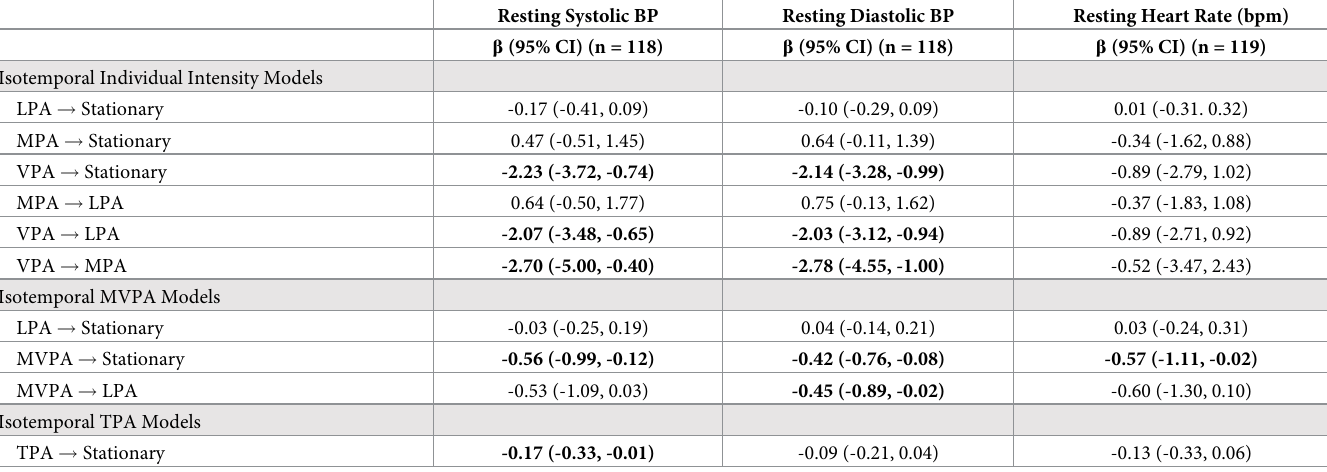
Table 3. Isotemporal substitution of movement behaviors with cardiovascular health indicators in preschool children with overweight and obesity participating in the baseline assessment of the TX CORD secondary prevention study (N = 131). Resting Systolic